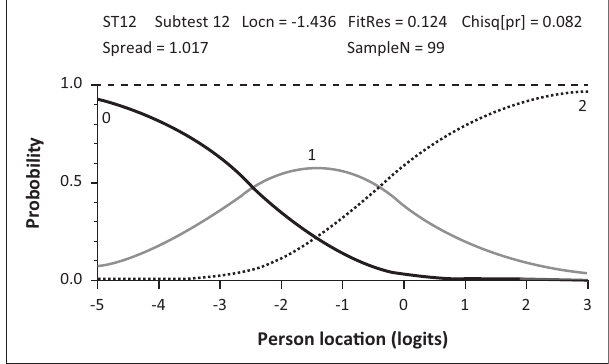
FIGURE 8: Subtest 12 (question 27A and